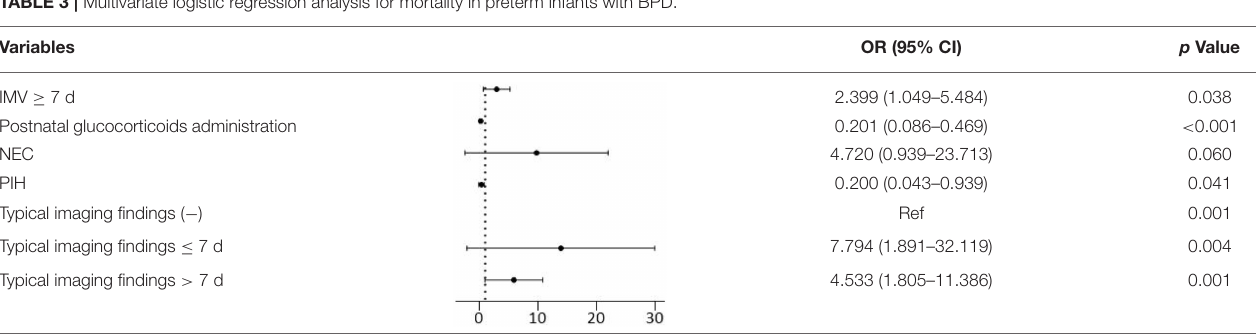
TABLE 3 | Multivariate logistic regression analysis for mortality in preterm infants with BPD.